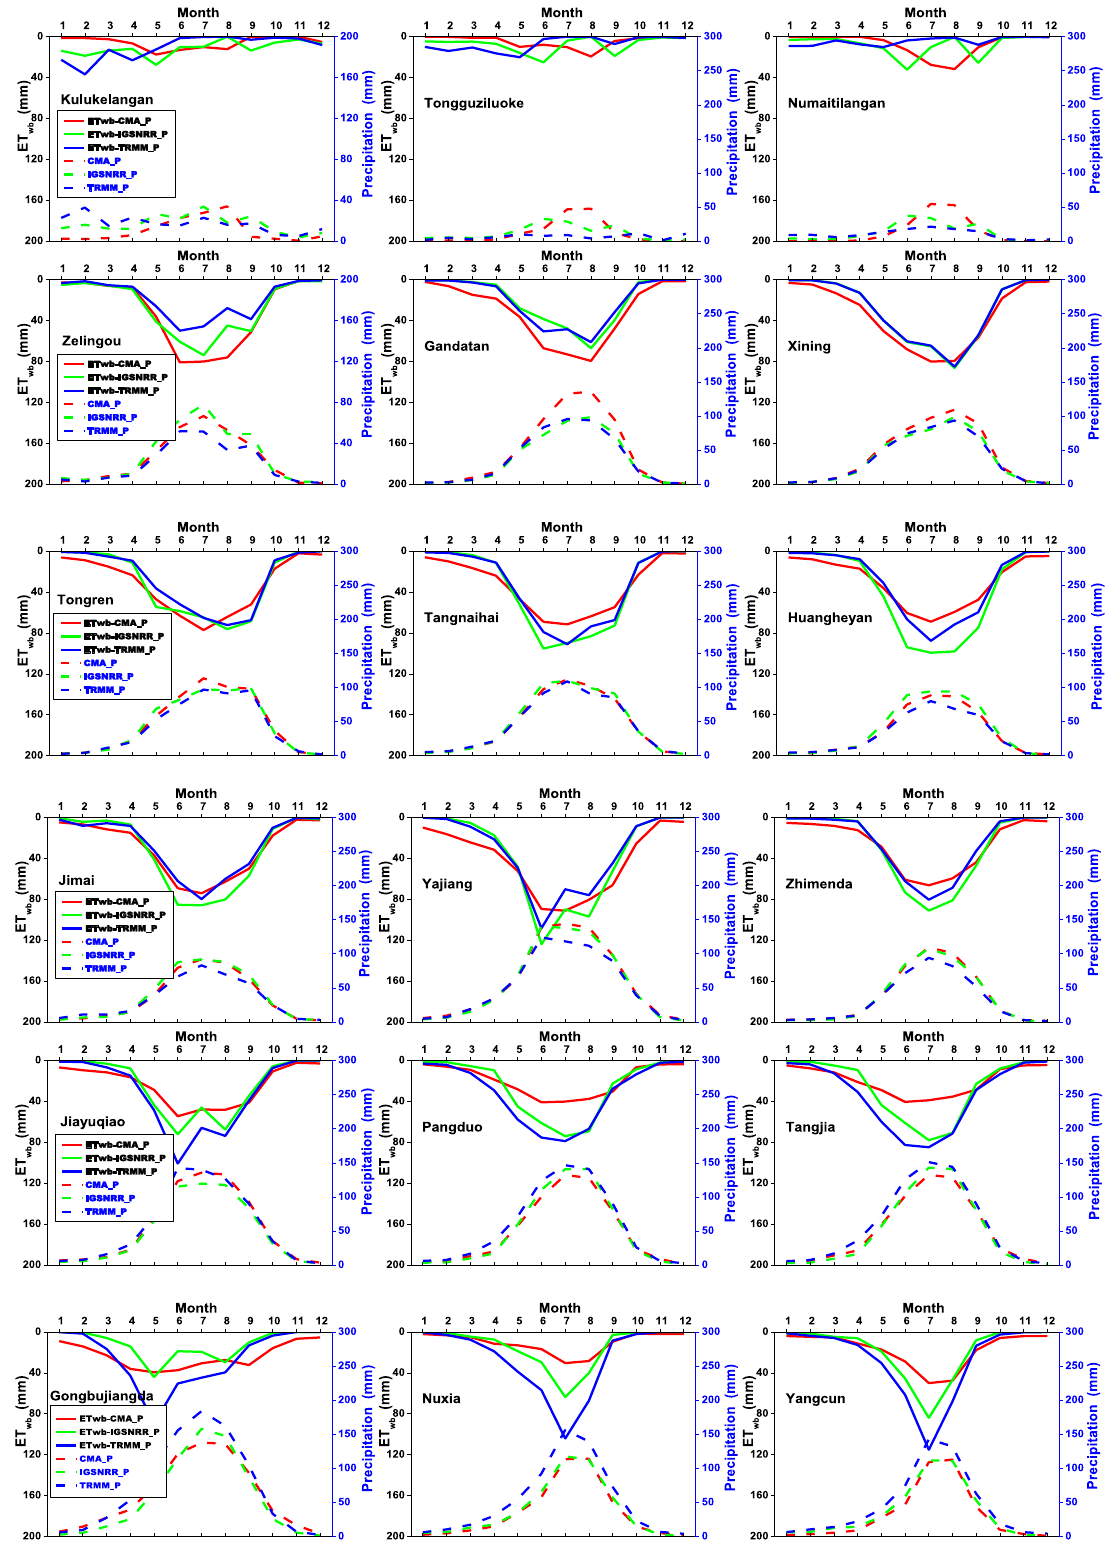
Figure 12. Uncertainties in seasonal cycles of ETwb calculated from three precipitation products (CMA gridded, IGSNRR_Forcing and TRMM precipitation) in 18 TP basins. The comparisons were conducted during the period 2000–2011 when TRMM data were